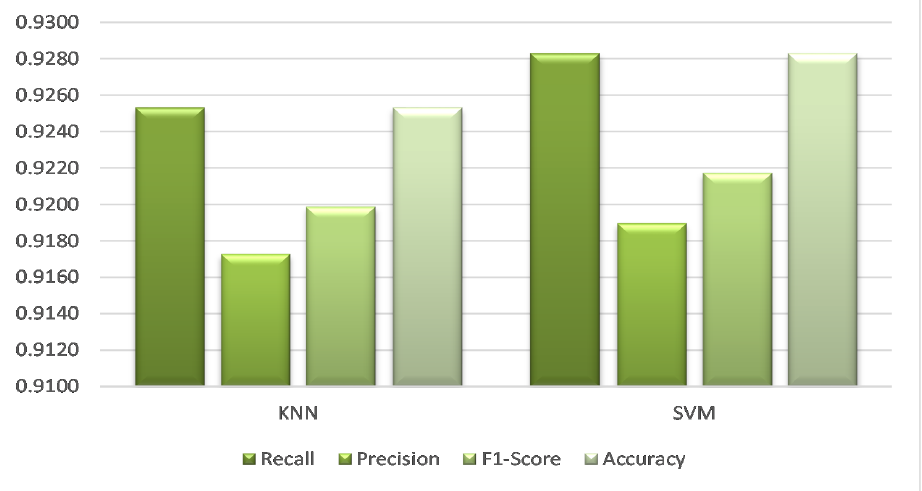
Figure 9. Average accuracy of classifiers on the selected